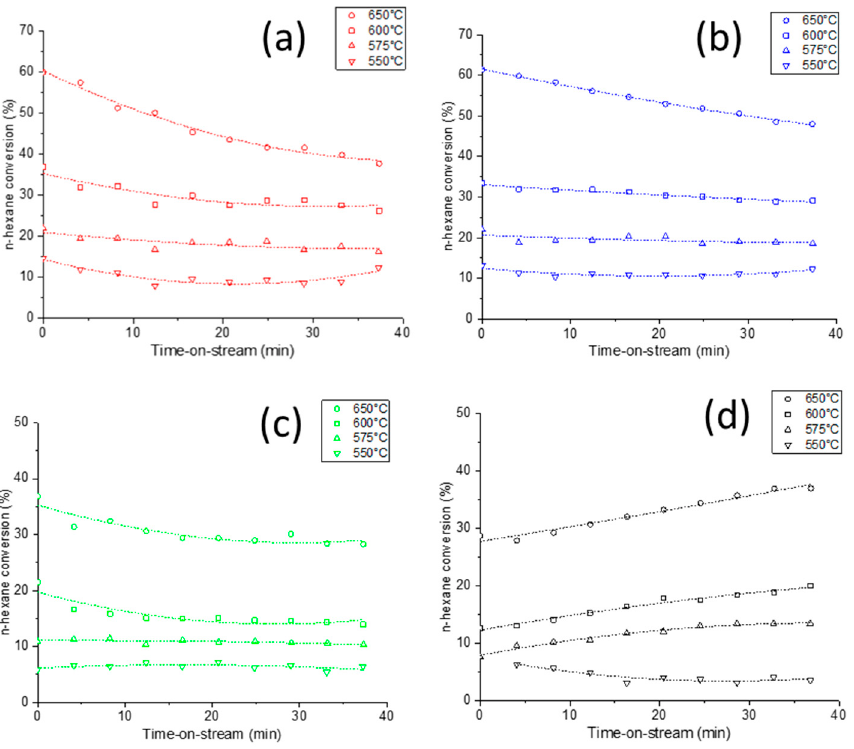
Figure 5. Conversion of n-hexane on ( a ) H-USY-0, ( b ) H-USY-1, ( c ) H-USY-2, and ( d ) H-Y at 550 ( (cid:72) ), 575 ( (cid:78) ), 600 ( • ), and 650 ◦ C ( (cid:4) ). Reaction conditions: catalyst 0.1 g; P n -hexane = 9 kPa; W/F nC6,0 = 3.9 g cat h/mol nC6 ; temperature 550–650 ◦